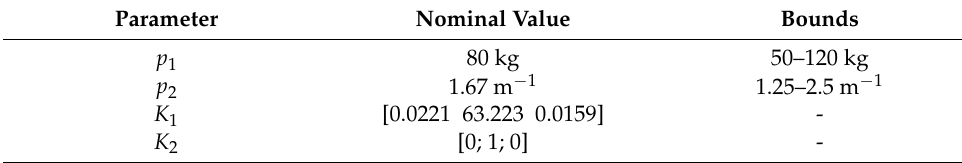
Table 4. Nominal values of parameters and feedback